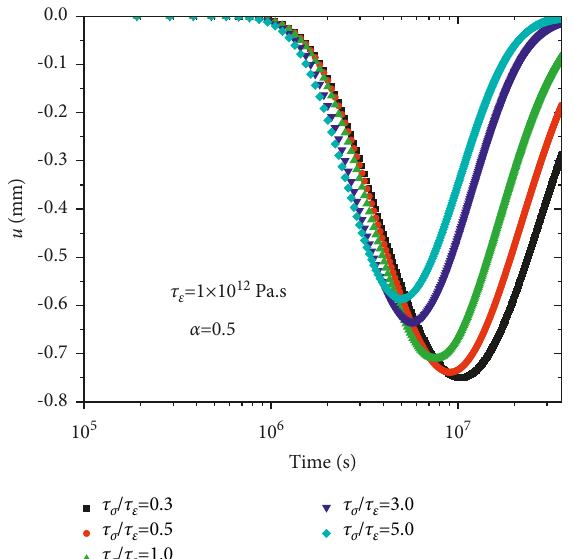
Figure 10: Influence of the material parameter τ